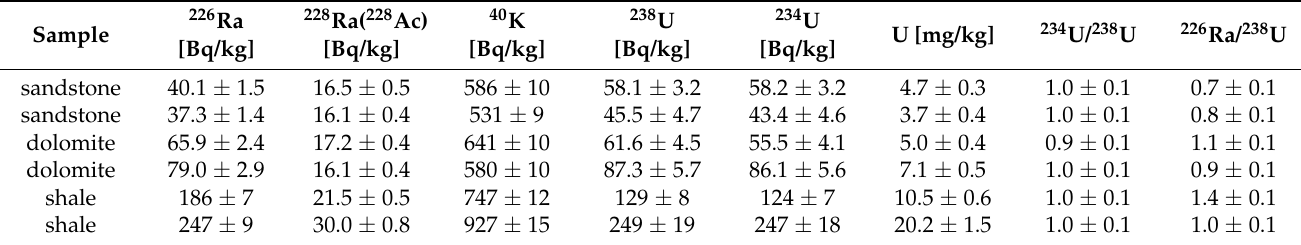
Table 2. Activity concentration of 226 Ra, 228 Ra, 40 K, 238,234 U, uranium content, 234 U/ 238 U, and 226 Ra/ 238 U activity ratios in investigated rock